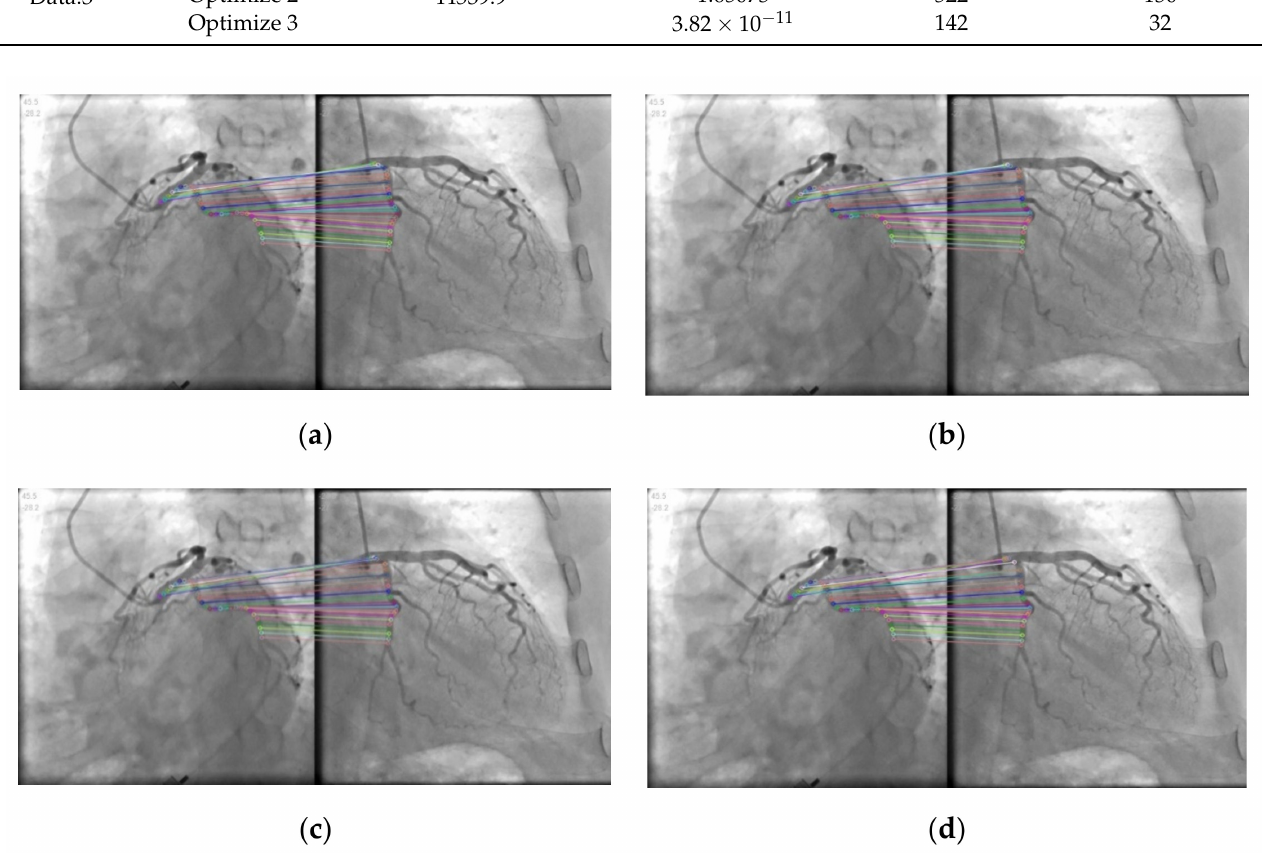
Figure 8. Matching results after different optimization. ( a ) is the result of Match 1; ( b ) is the result